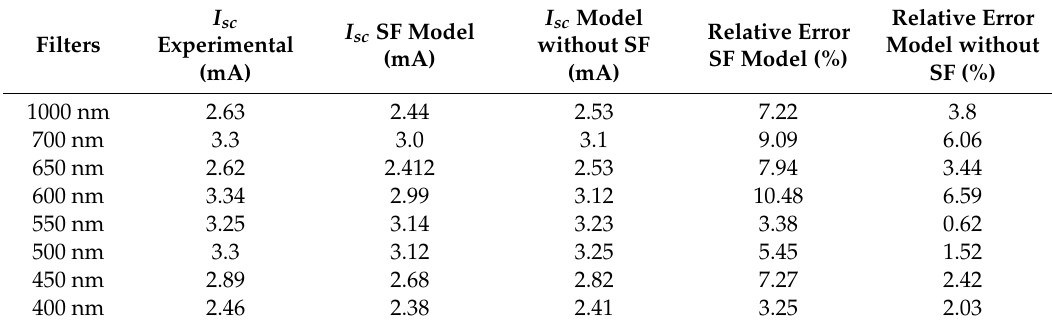
Table 10. Values of short-circuit current and their respective relative errors for BP filters. I sc I sc SF Model Filters Experimental Table 9. Values of short-circuit current and their respective relative errors for HP filters. (mA) Day Hour Filter